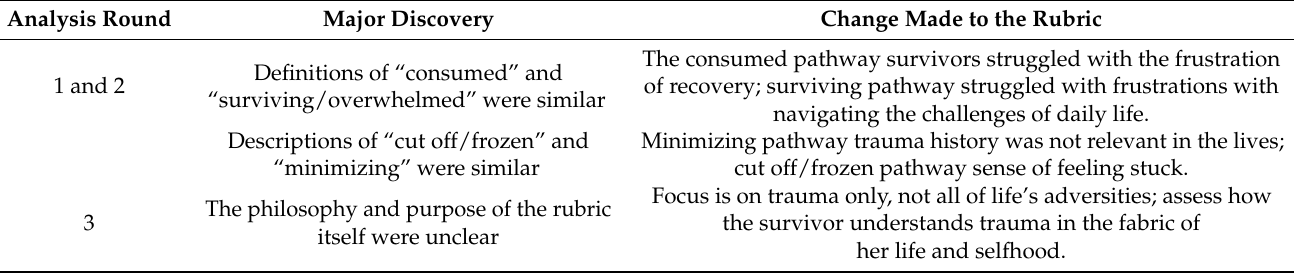
Table 1. Summary of rubric